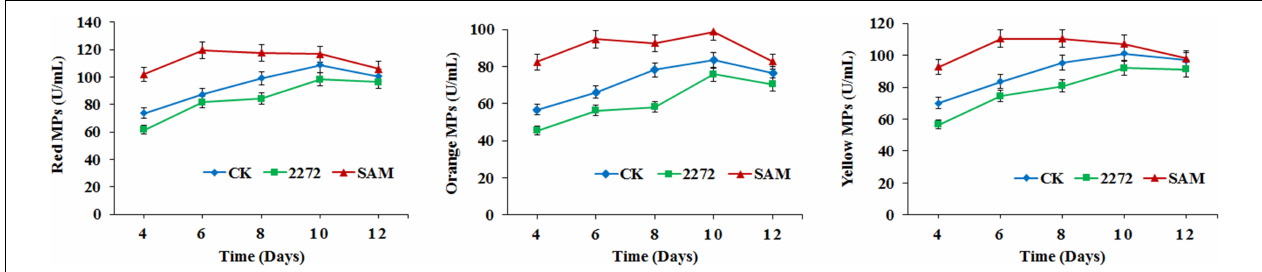
FIGURE 3 | Monascus pigments production in M. purpureus RP2 and M. purpureus 2272. CK, M. purpureus RP2 fermentation without addition of amino acid; 2272, M. purpureus 2272 fermentation without addition of amino acid; (SAM), M. purpureus RP2 fermentation with addition of 1 g/L SAM.